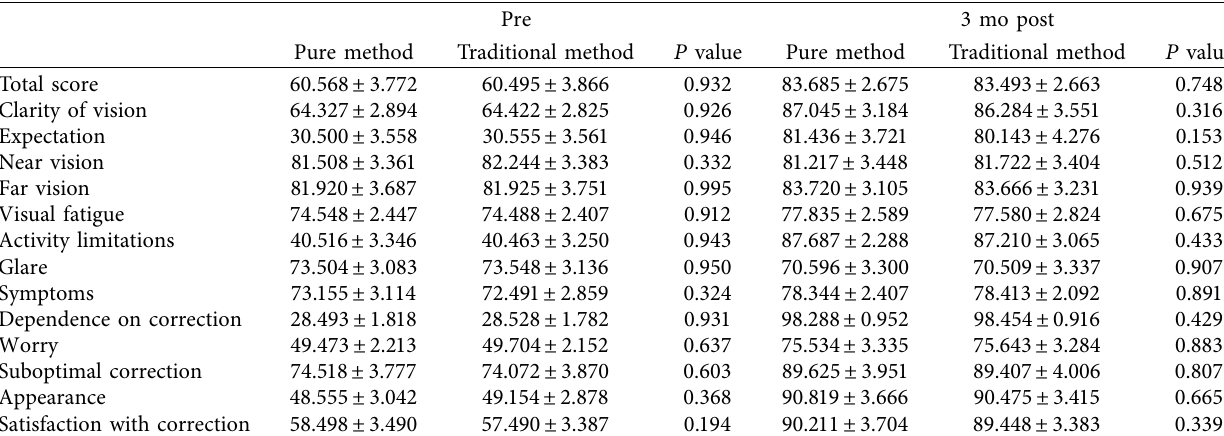
Table 7: NEI-RQL-42 scores before and 3 months after surgery in the pure ICL implantation and traditional ICL implantation groups.